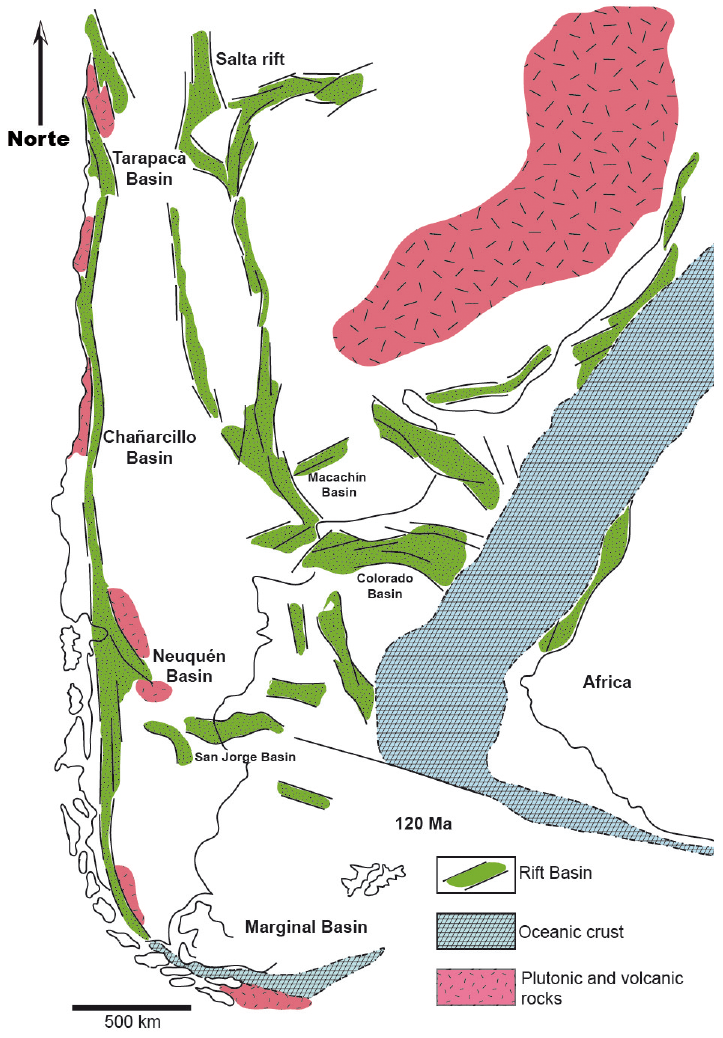
Figure 2. Main rift systems developed in southern South America during the Gondwana–Pangea break-up (Ramos and Aleman,